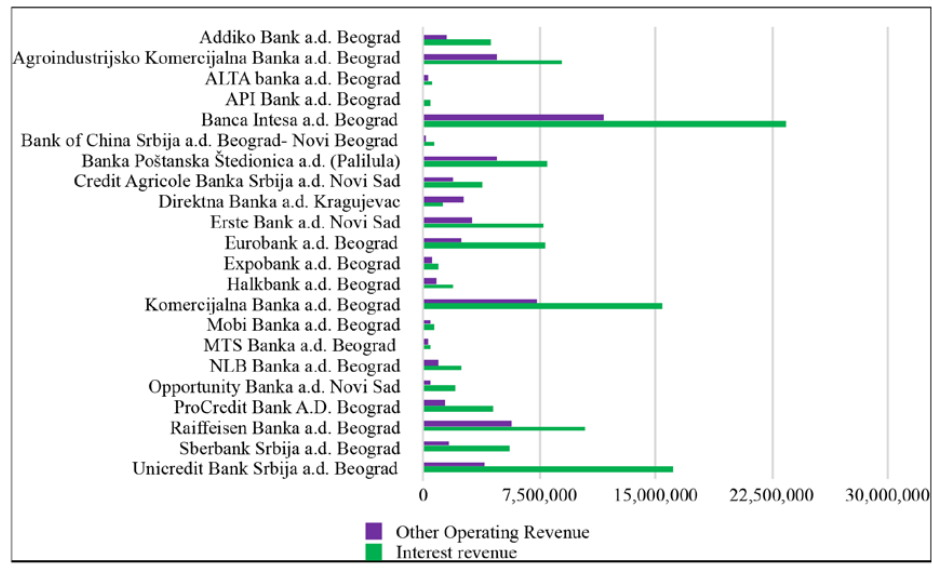
Figure A6. Mean for the outputs for each bank.